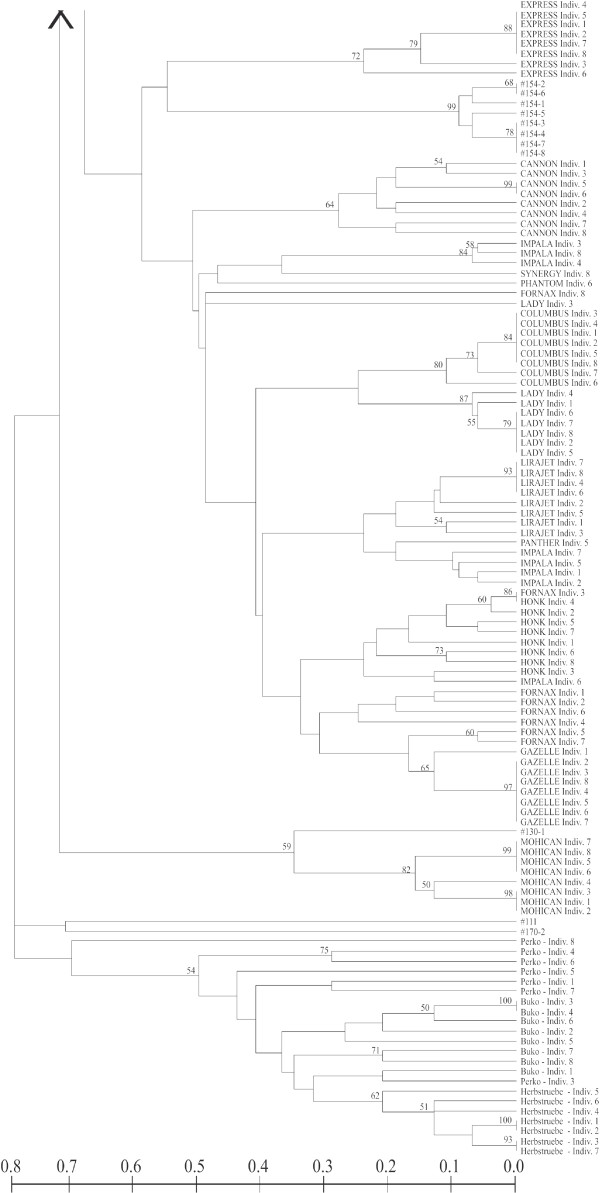
Relationship among single individuals of B. napus based on Nei and Li genetic distances and UPGMA. Figure 2 continued, for detailed description see Figure 2.